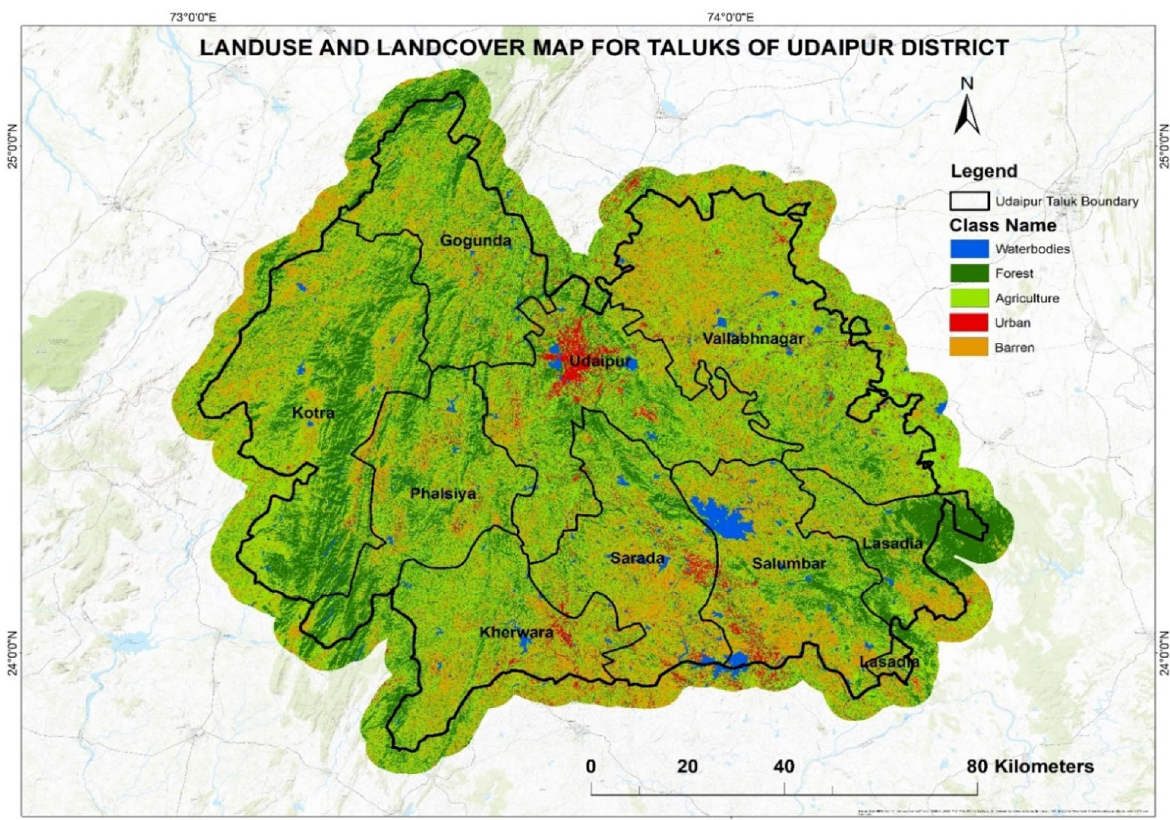
Fig. 5 Spatial distribution of different land use-land cover classes over the